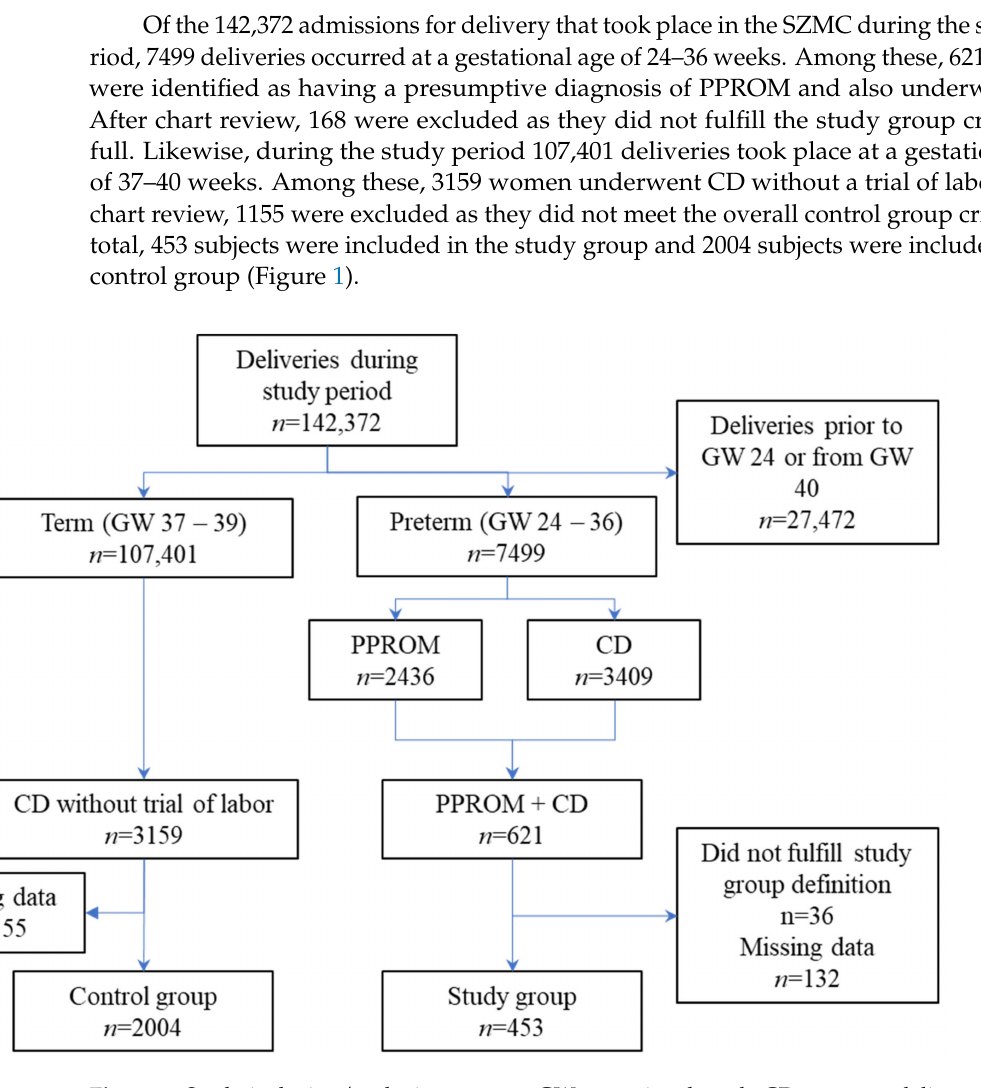
Figure 1. Study inclusion/exclusion process. GW: gestational week; CD: cesarean delivery; PPROM: preterm premature rupture of